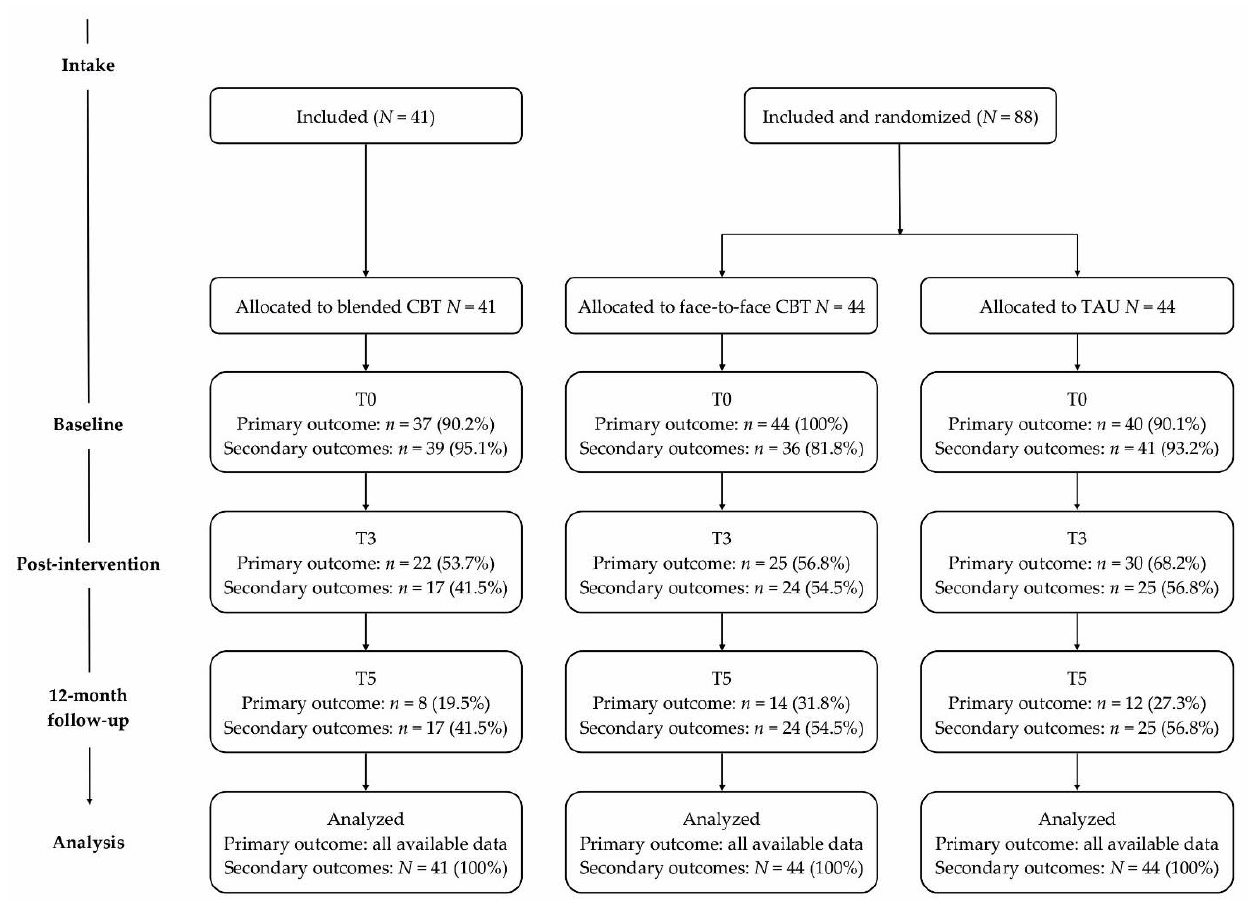
Figure 1. Flow diagram of participants.